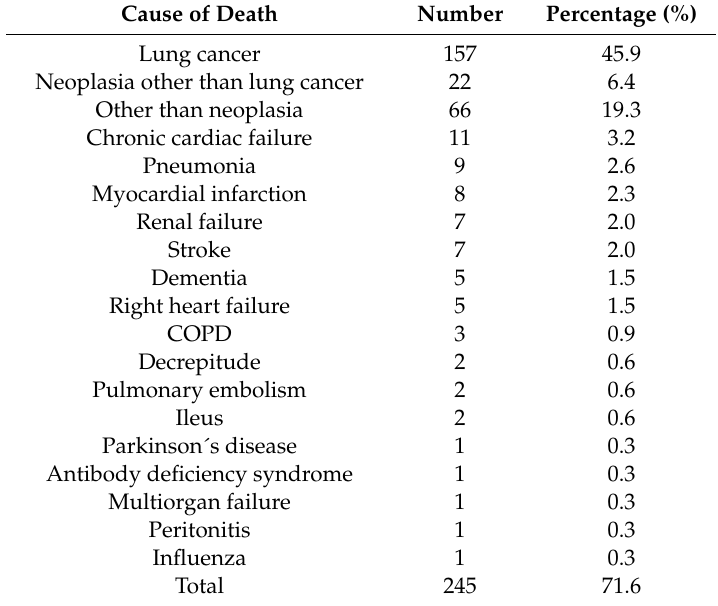
Table 3. Causes of death of those 245 patients undergoing curative resection for non-small-cell lung cancer.